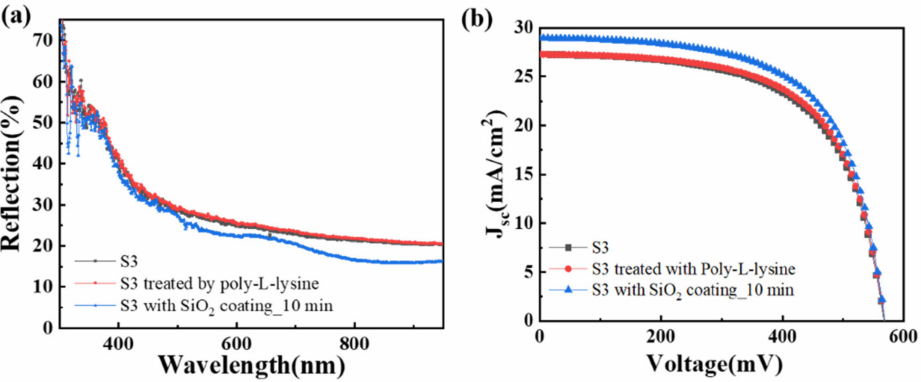
Figure 7. The reflection spectra and current density-voltage characteristics of the solar cells were treated only with poly- L -lysine and after deposition of SiO 2 nanospheres: ( a ) Reflection spectra and ( b ) Current density-voltage characteristics of the original solar cell (S3, black): S3 after being treated by poly- L -lysine (red), and S3 with 10 min self-assembly of SiO 2 nanosphere